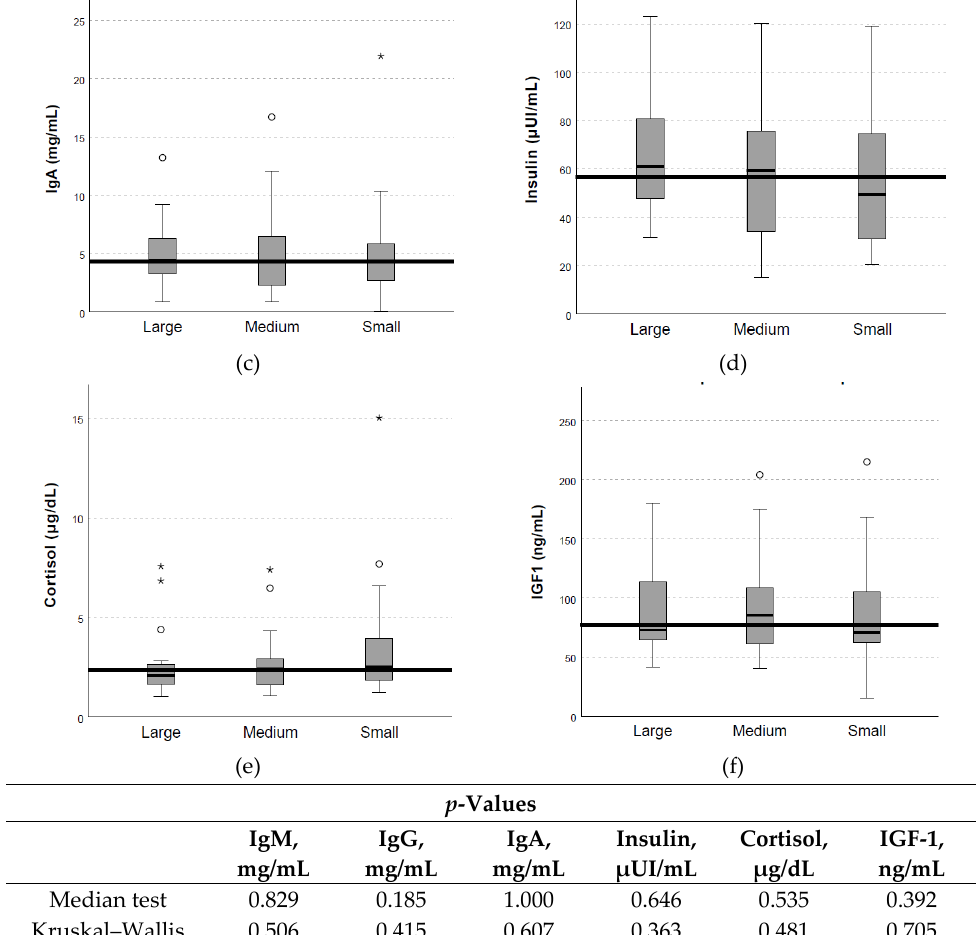
Figure 4. Effect of body weight at first service on serum immunoglobulin concentrations: ( a ) IgM, ( b ) IgG, ( c ) IgA, ( d ) insulin, ( e ) cortisol, and ( f ) IGF-1. Weight group at first service: (1) Large sow (>150 kg BW; n = 16); (2) Medium sow (135–150 kg BW; n = 32); (3) Small sow (<135 kg BW; n = 32). Solid horizontal line represents global median for each blood metabolite. No significant differences were detected between weight groups of gilts ( p > 0.05). ◦ , *: outliers are identified with different markers for “out” (small circle) and “far out” (marked with a star), the latter SPSS also calls “extreme